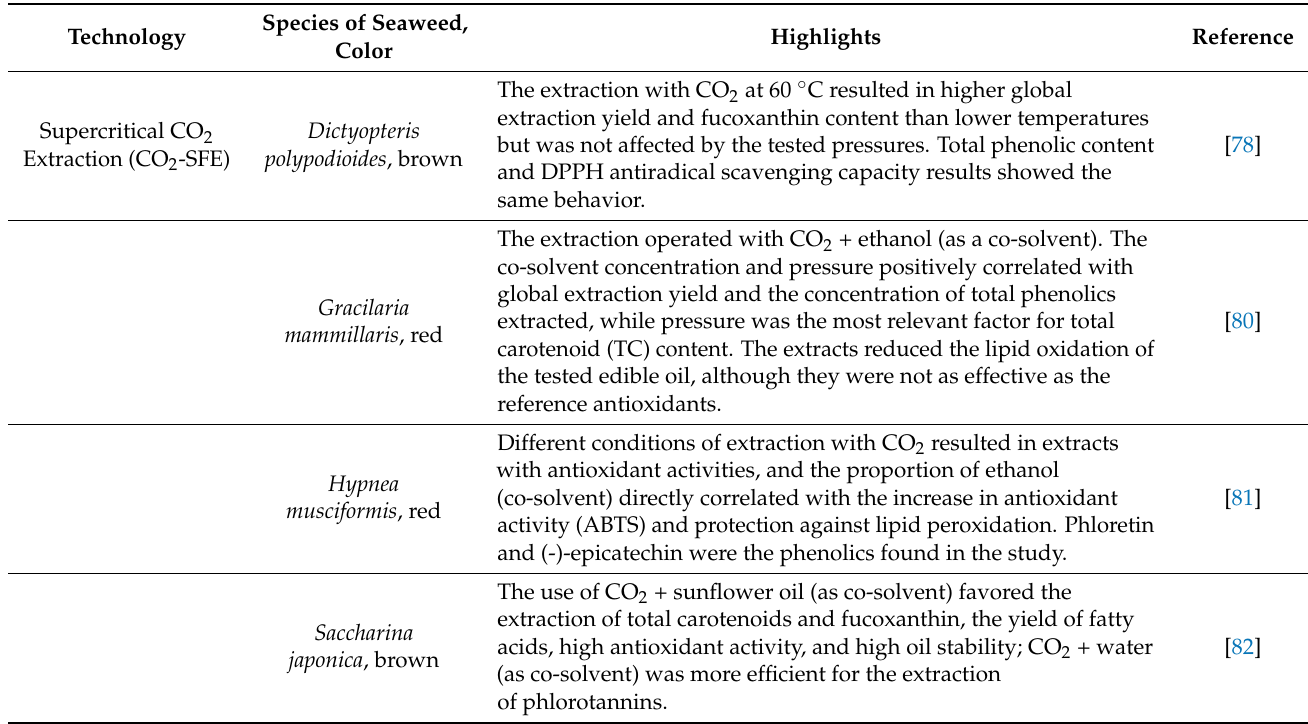
Table 5. Production of sustainable ingredients from some macroalgae through green technologies. Technology Highlights